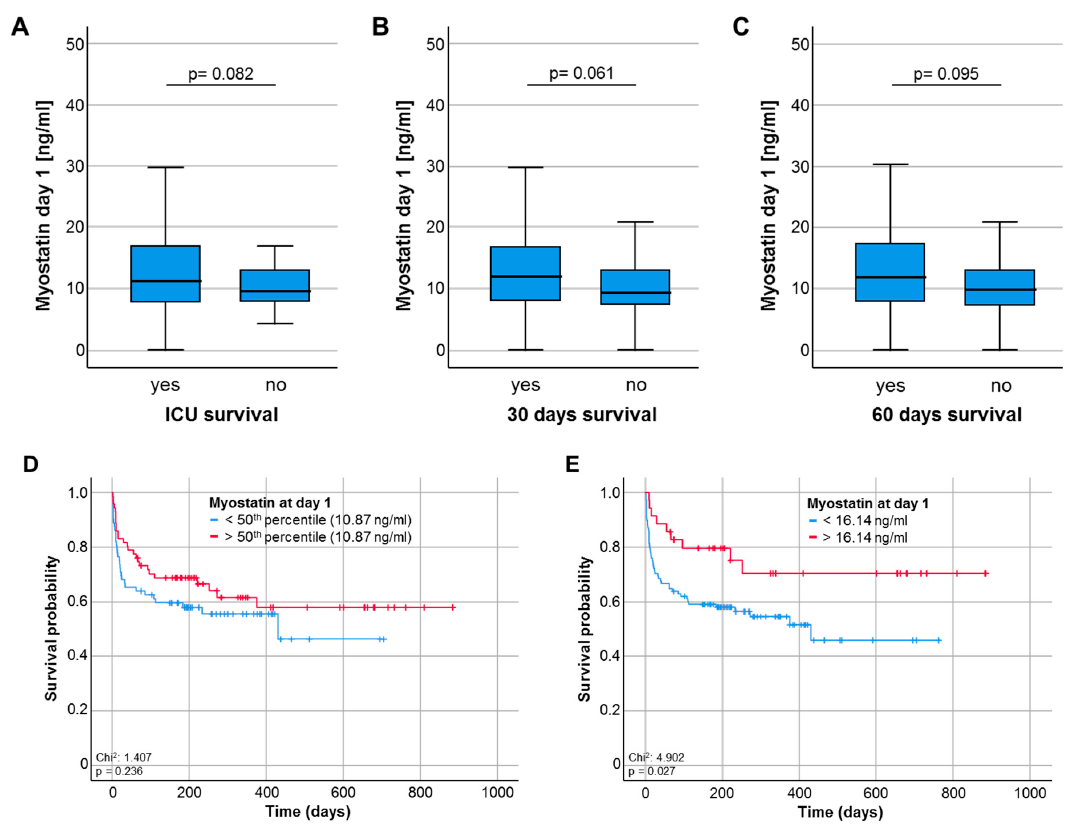
Figure 3. Low baseline Myostatin levels predict poor outcome in critically ill patients. ( A ) Patients who deceased on the ICU show a trend towards lower Myostatin levels compared to ICU survivors ( p = 0.082). ( B ) Patients who deceased during the first 30 days following ICU admission show a trend towards lower serum Myostatin levels compared to survivors ( p = 0.061). ( C ) Patients who deceased during the first 60 days following ICU admission show a trend towards lower serum Myostatin levels compared to survivors ( p = 0.095). ( D ) Using the median Myostatin serum level (10.87 ng/ml) as cut-off value, Kaplan–Meier curve analysis reveals a trend towards an impaired overall survival (OS) in patients with low Myostatin serum levels at ICU admission. ( E ) When applying the ideal cut-off value, patients with a baseline Myostatin serum levels below 16.14 ng/ml have a significantly impaired OS compared to patient with Myostatin levels above the cut-off value ( p = 0.027).